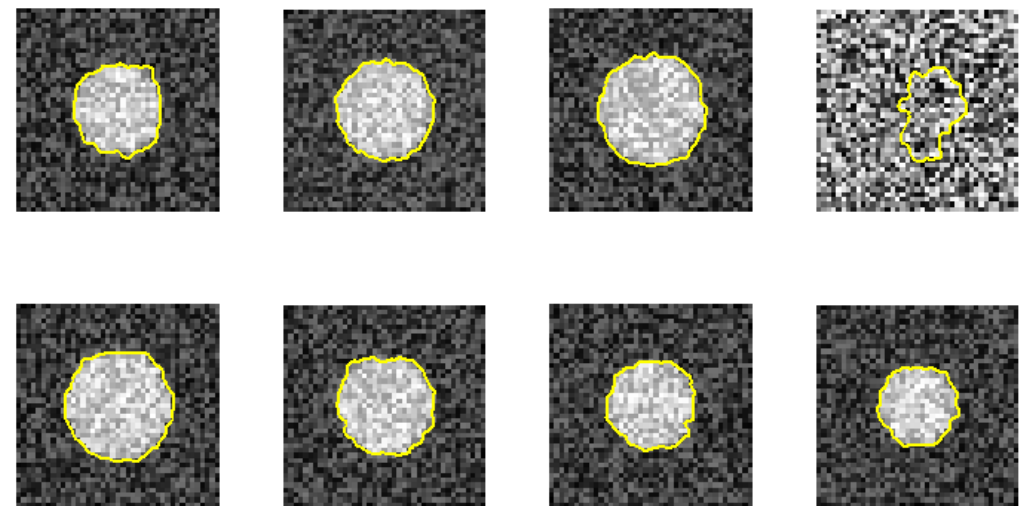
Figure 8. The traditional DP fails to hold the contour, as there is no information between image